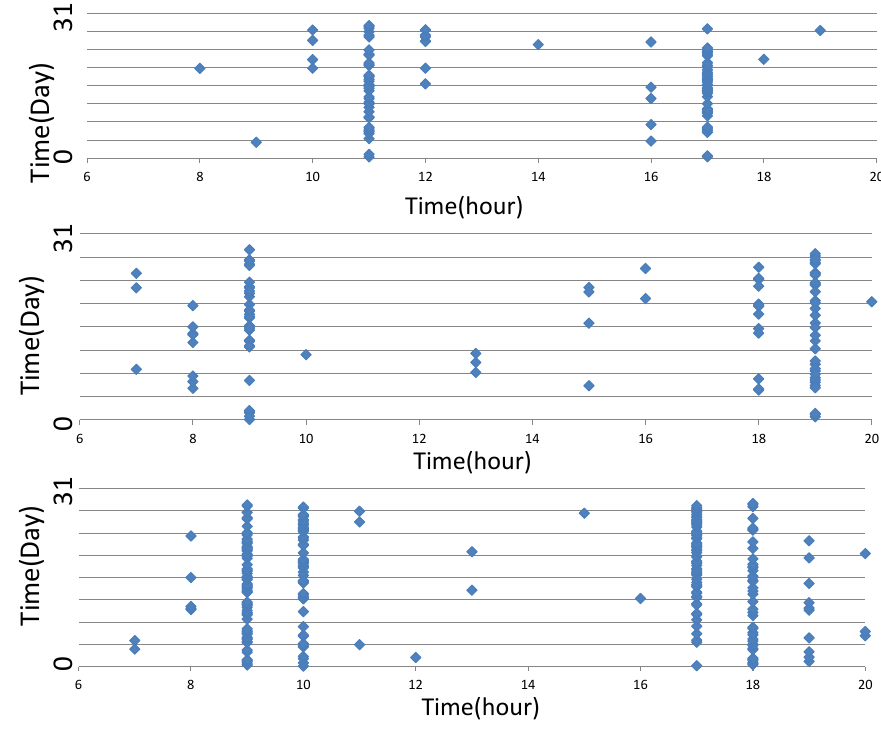
Figure 5. Individual data differences in Bus Line 1 trips.